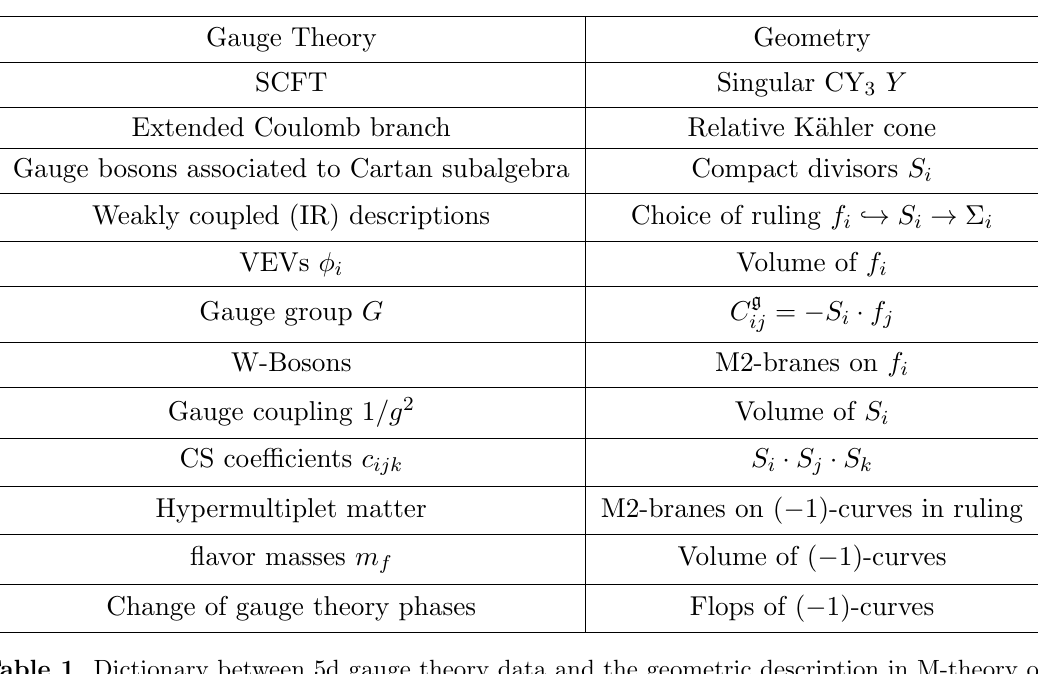
Table 1 . Dictionary between 5d gauge theory data and the geometric description in M-theory on a CY 3